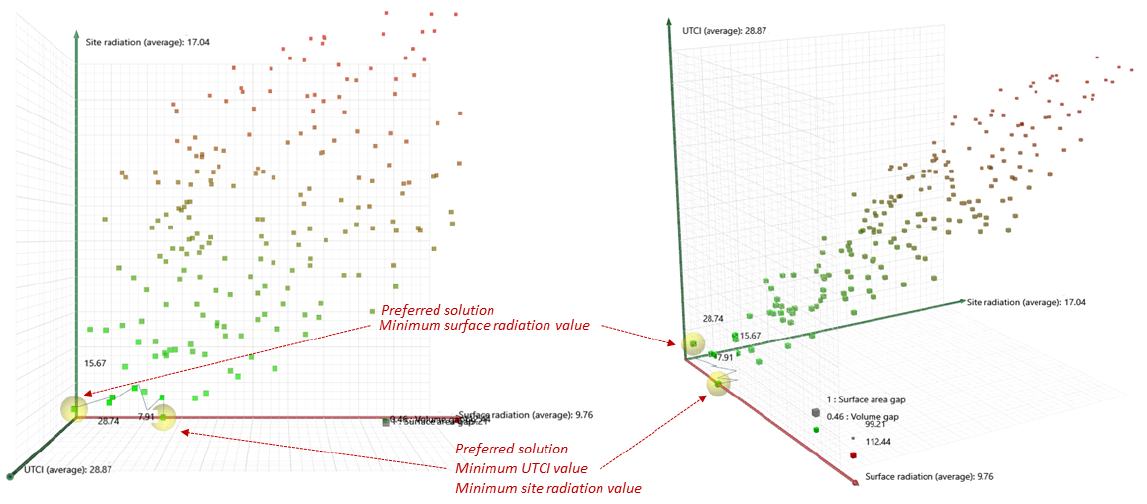
Fig. 4. 3D population field of the optimization result, top and perspective view. bution in the population field, the targeted model for the minimum site radiation is the same as the minimum UTCI model. Hence, there are only two desired solutions will be reinstated and compared with the benchmark model’s per- reinstating solution process from a single